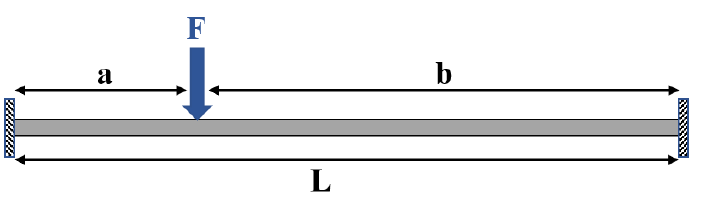
Figure 3. ( a ) Schematic of the constant bending radius principle, ( b ) schematic of the variable bending radius principle.